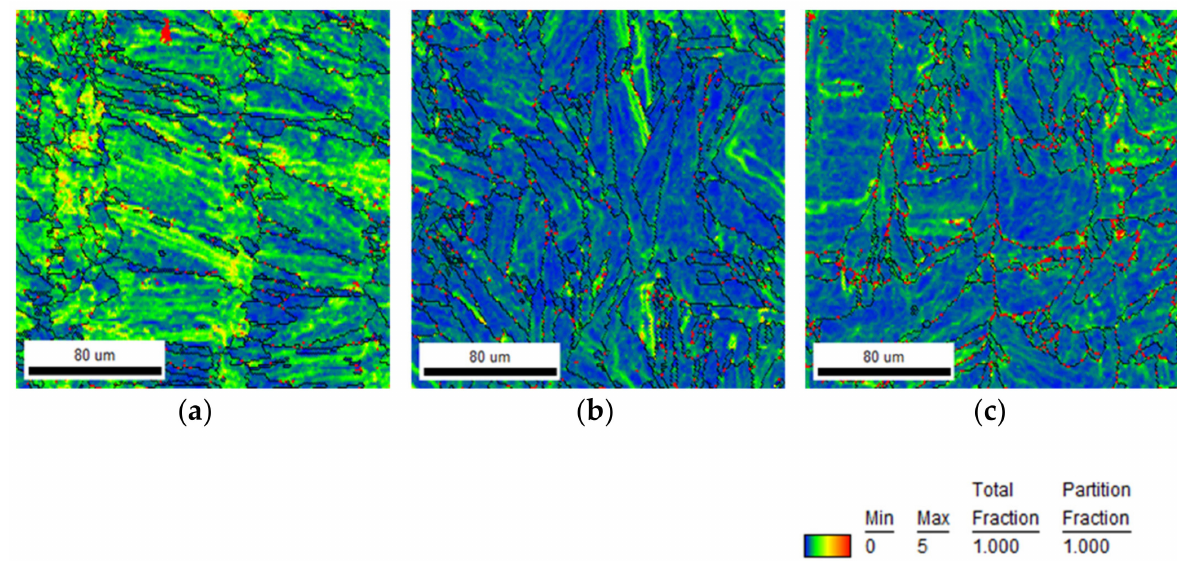
Figure 15. Kernel average misorientation (KAM) maps of the xy section of tensile test specimens before the tensile test fabricated in the direction of ( a ) 0 ◦ , ( b ) 45 ◦ , and ( c ) 90 ◦